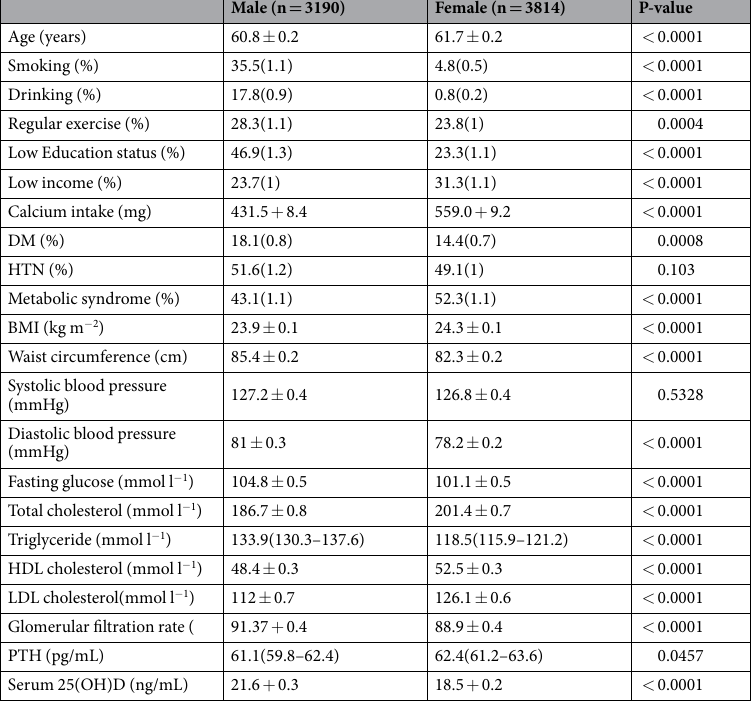
Table 1. Baseline characteristics total population BMI, body mass index; LDL, low-density lipoprotein; HDL, high-density lipoprotein; HOMA-IR, homeostasis model assessment of insulin resistance; PTH, parathyroid hormone; Normal range of PTH is 8–76 pg/mL. Data are expressed as the means ± standard error (SE), percentage (SE) or geometric means (95% confidence interval). Low educational status: subject with elementary to middle school. Low income: the lowest